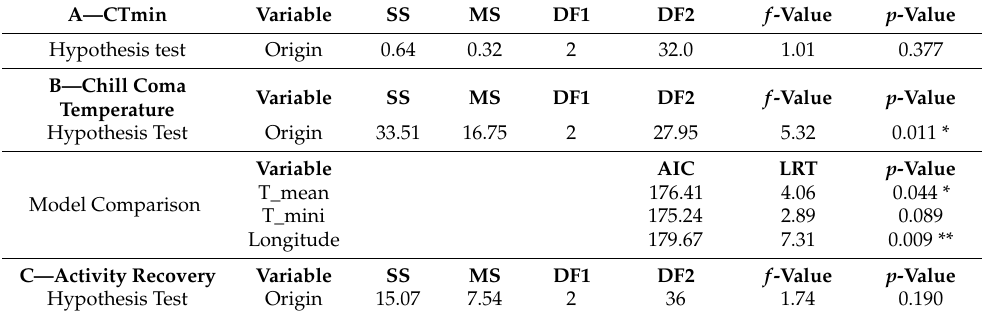
Table 3. Statistical significance of fixed